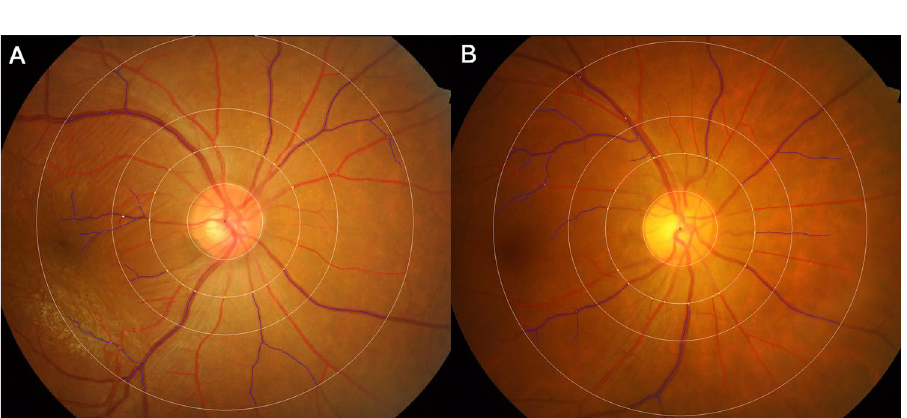
Figure 1. The geometric measurement of the retinal vasculature assessed by the Singapore I Vessel Assessment (SIVA) software of an eye with idiopathic epiretinal membrane (ERM) ( A ) and a normal control ( B ). ( A ) The retinal calibers of the arterioles and venules are 175.20 and 230.05 µm, respectively, the fractal dimensions of the arterioles and venules are 1.244 and 1.087, respectively, the tortuosity values of the arterioles and venules are 0.663 × 10 –4 and 0.569 × 10 –4 , respectively, and the branching angles of the arterioles and venules are 65.14 and 71.86°, respectively. B. The retinal calibers of the arterioles and venules are 168.16 and 199.17 µm, respectively, the fractal dimensions of the arterioles and venules are 1.309 and 1.098, respectively, the tortuosity values of the arterioles and venules are 0.556 × 10 –4 and 0.356 × 10 –4 , respectively, and the branching angles of the arterioles and venules are 62.79 and 76.76°,